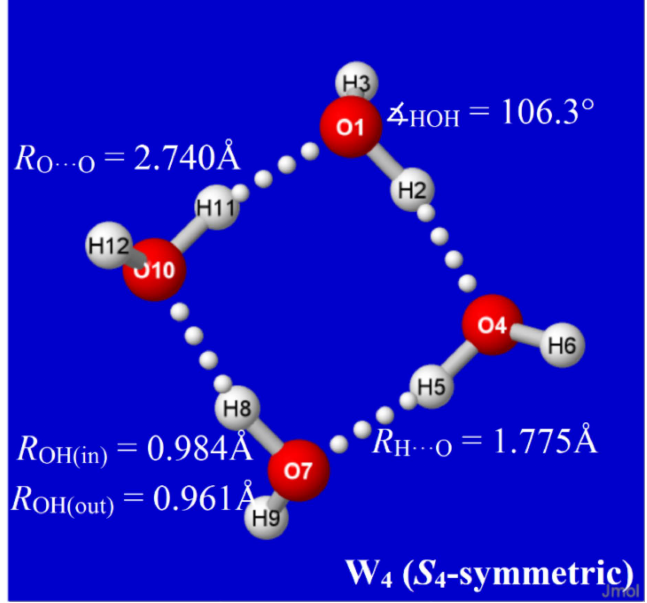
Figure 1. Equilibrium structural properties of cyclic (H 2 O) 4 “windowpane” cluster (B3LYP/6- 311++G**